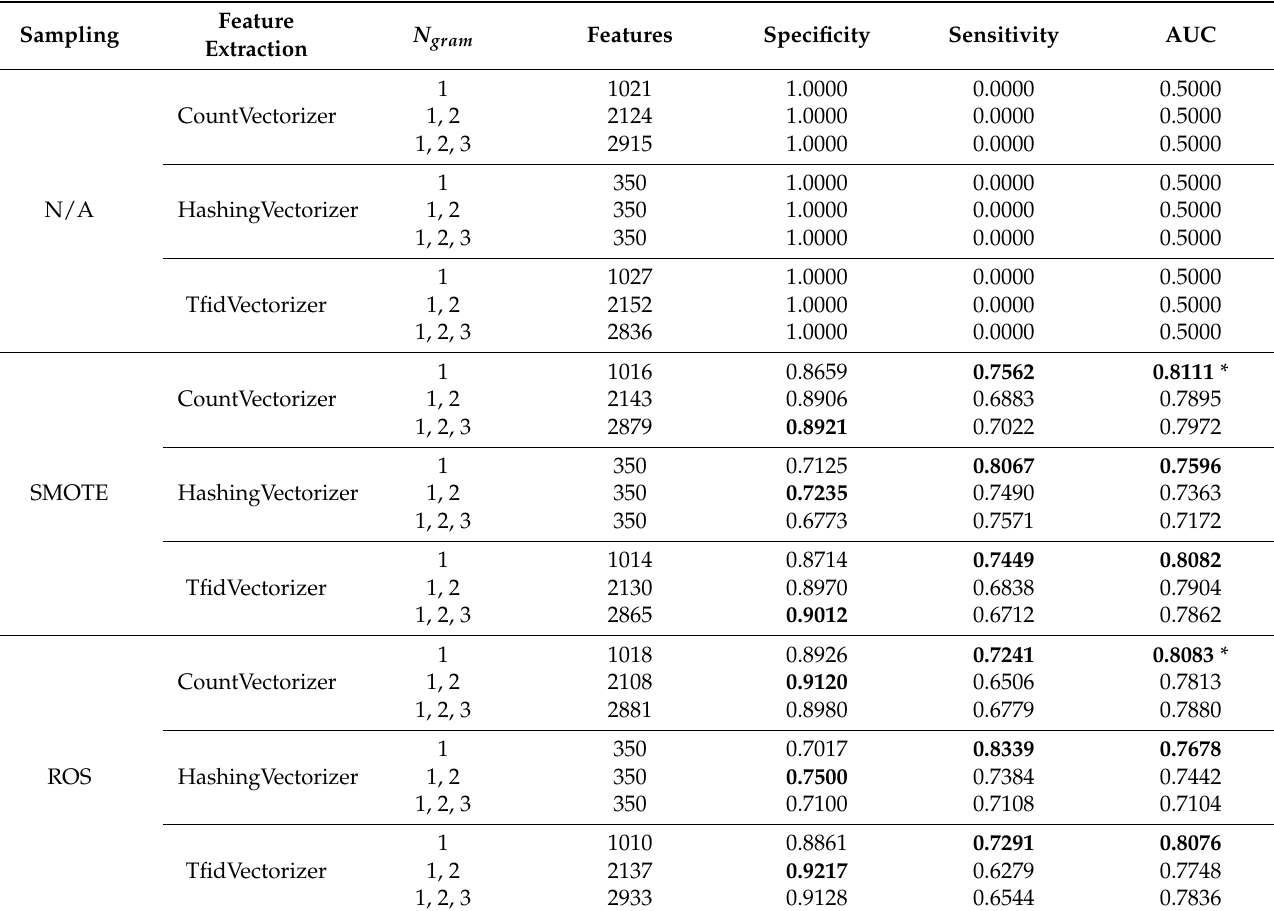
Table 2. Classification results obtained after applying feature extraction and two sampling methods, using a deep learning multilayer perceptron (DL-MLP) as classifier. Best results (in bold) and the best AUC for each sampling method (marked with a star) are also